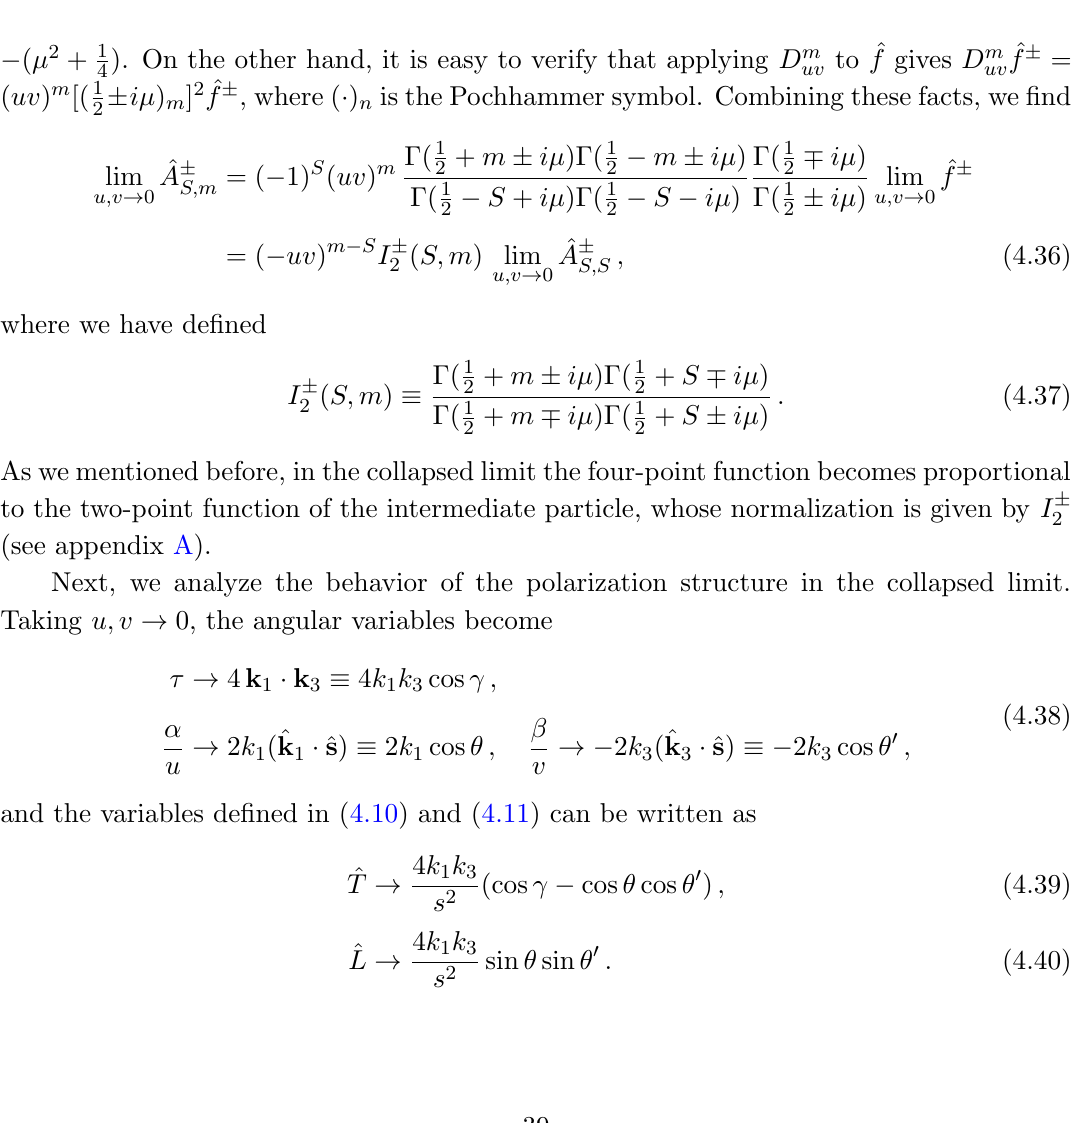
Figure 8. Illustration of the angles used in (4.38) and